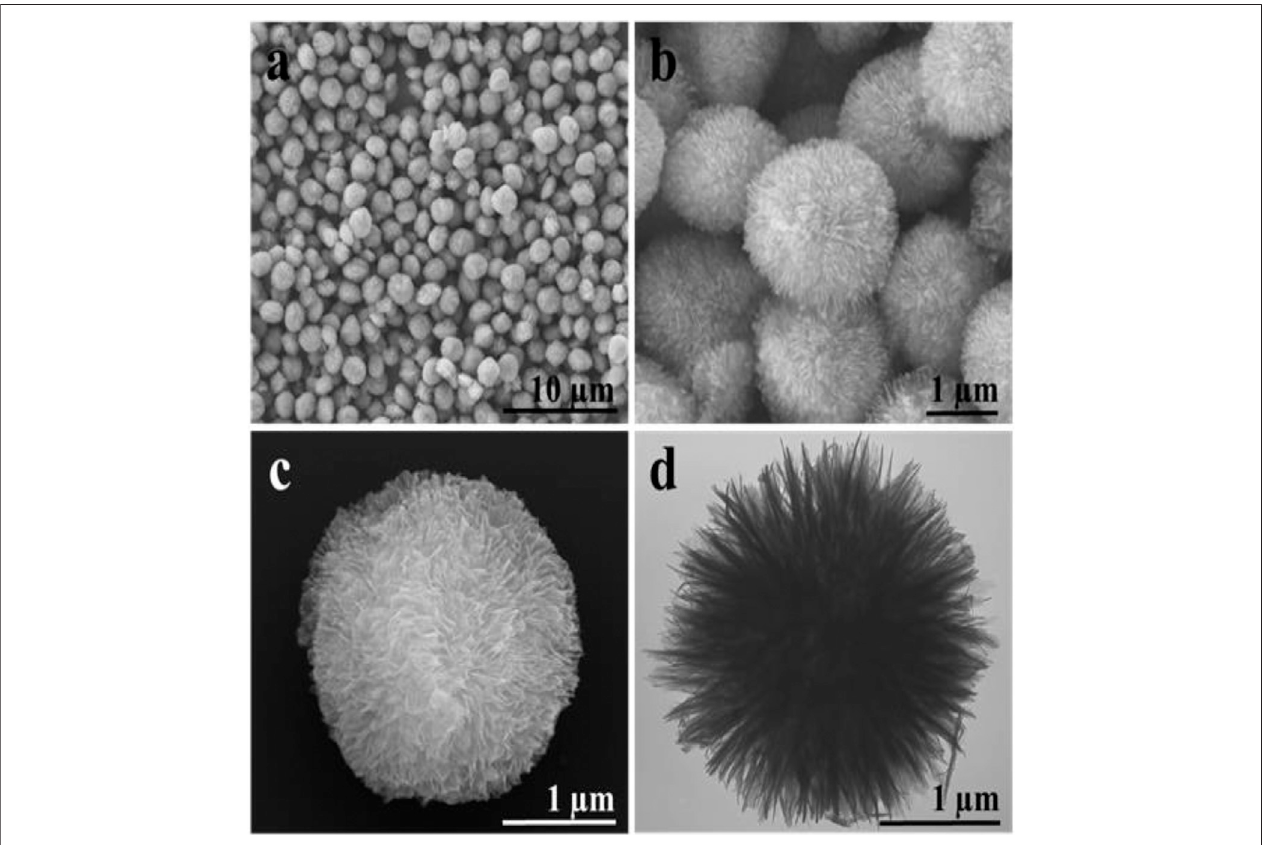
FIGURE 1 | (A – C) Scanning electron microscope and (D) transmission electron microscopy images of porous TiO 2 spheres with different magni fi